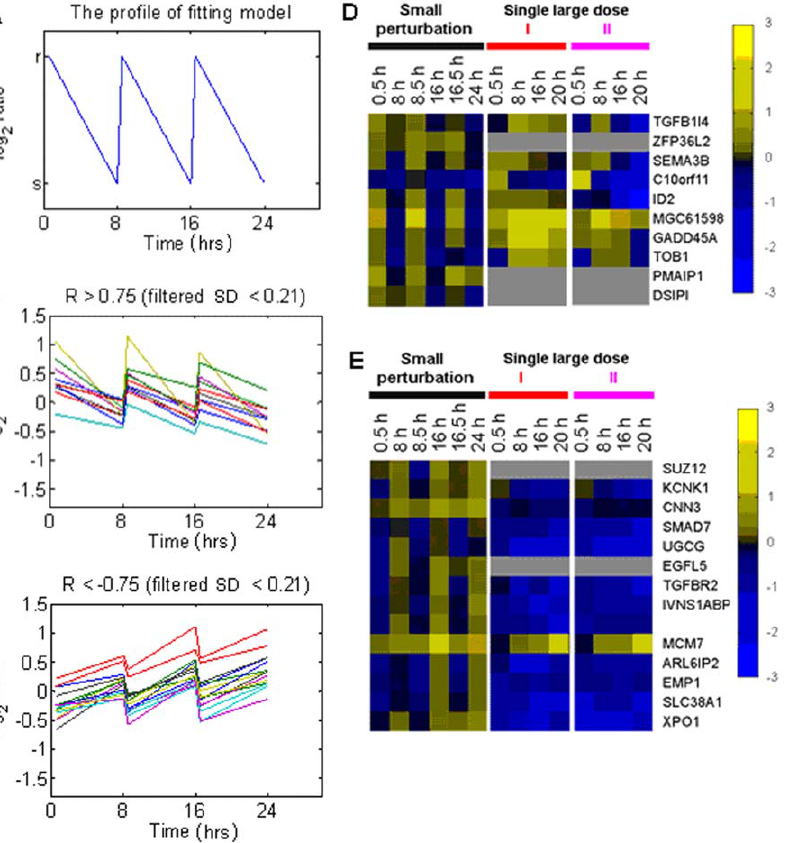
Figure 2. Results of steady-state model-fitting algorithm and the corresponding expression profiles of single large dose treatments. A ) The profile of the fitting model. r and s are both arbitrary constants. Only genes with profiles of gene expression which changes significantly over time points (SD . 0.21) were applied model-fitting algorithm. B and C ) The expression profiles of genes with correlation coefficient, R, more than 0.75 (positive correlation) and less than 2 0.75 (negative correlation), respectively. Genes with correlation coefficient absolute value, |R|, greater than 0.75, as shown in ( B ) and ( C ) were considered to have a steady-state response. D and E ) Steady-state genes that correlated positively ( D ) and negatively ( E ) with the model were randomly permuted in these two cases. Up and down regulation are presented by yellow and blue boxes, respectively; grey boxes indicate missing data. The gene expression profiles of the two groups of genes with small perturbation exhibit steady-state characteristics. For single large dose I (233 J/m 2 of UVB) or single large dose II (582.5 J/m 2 of UVB), the steady-state characteristics of the gene expression disappeared.